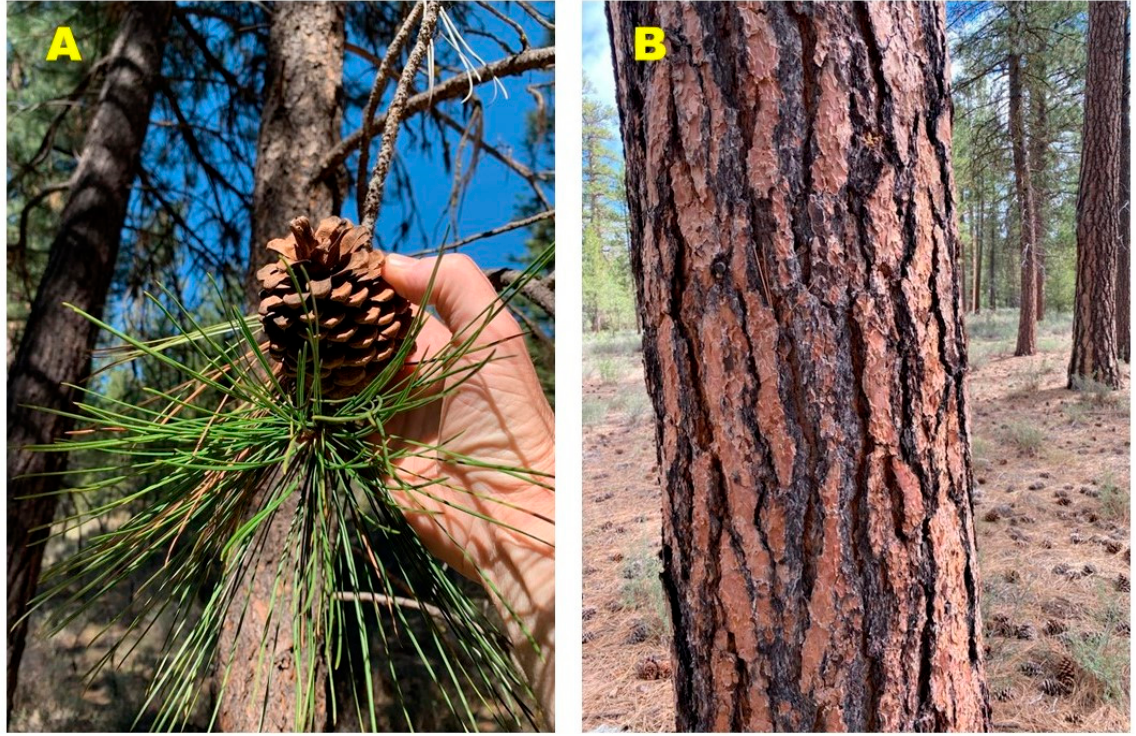
Figure 1. Pinus ponderosa var. ponderosa from central Oregon. ( A ) Leaves (needles) and cone. ( B )